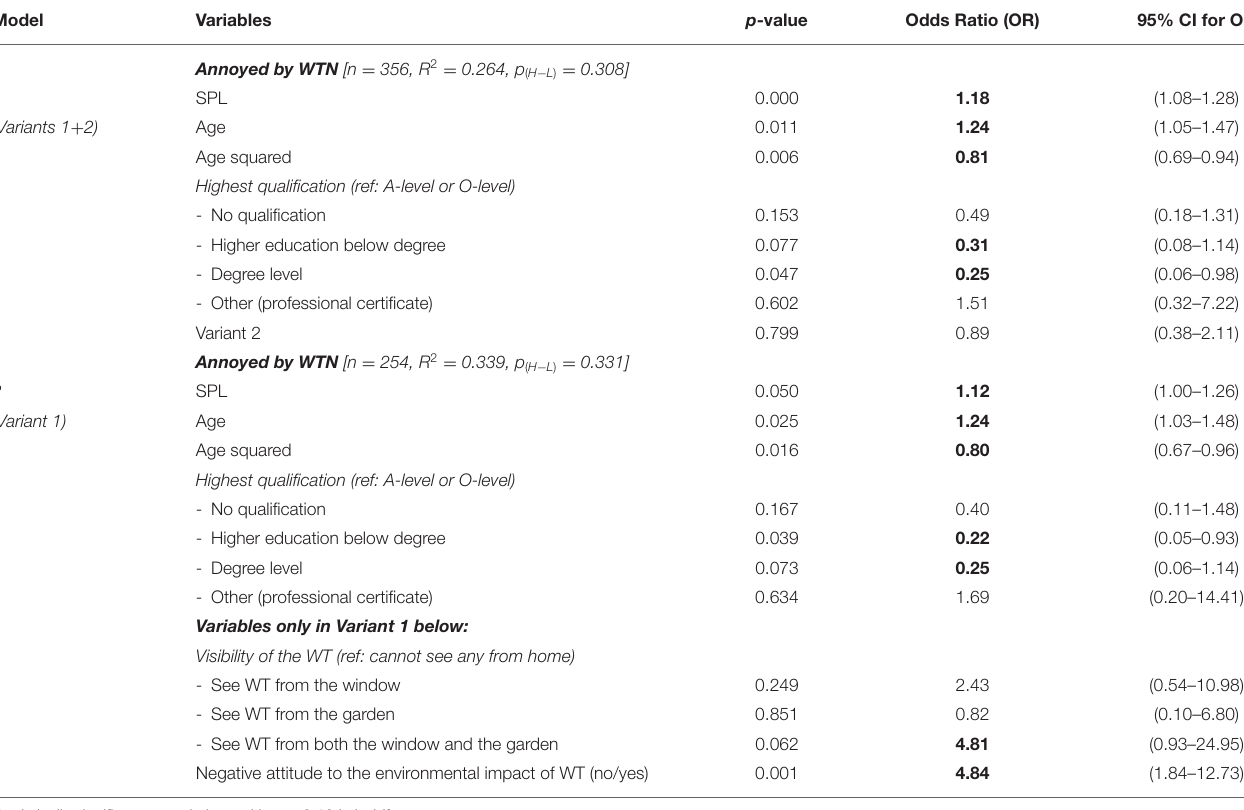
TABLE 2 | Association among annoyed by WTN, sound pressure levels (SPLs), and covariates. Model